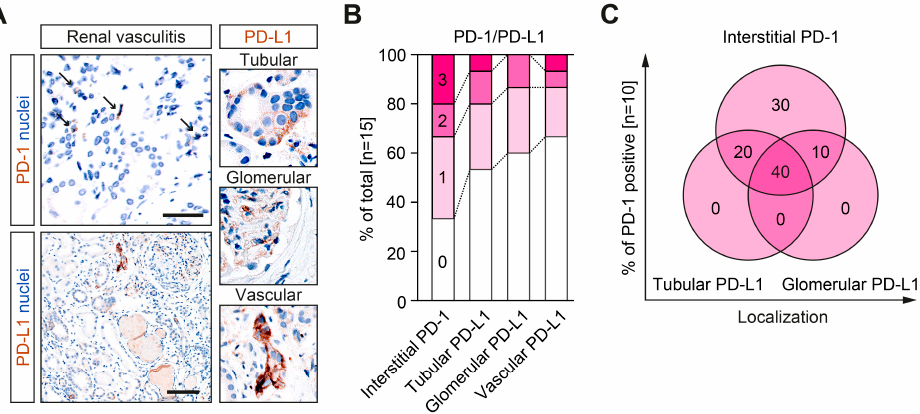
Figure 1. Immune checkpoints PD-1 and PD-L1 are present in different renal compartments in ANCA-associated renal vasculitis. ( A ) Immunostainings for PD-1 (scale bar: 40 μ m) and PD-L1 (scale bar: 100 μ m) are shown; counterstaining was performed by using hematoxylin. Presence of PD-1 was limited to interstitial cell positivity (arrows); PD-L1 was found in the tubular, glomerular and vascular compartment in ANCA-associated renal vasculitis. ( B ) Quantification of PD-1 and PD-L1 is shown as fraction of total (n = 15). ( C ) Among cases with interstitial PD-1 (n = 10), frequency of tubular and glomerular PD-L1 positivity is shown. In case of PD-1 positivity, most were also positive for tubular and/or glomerular